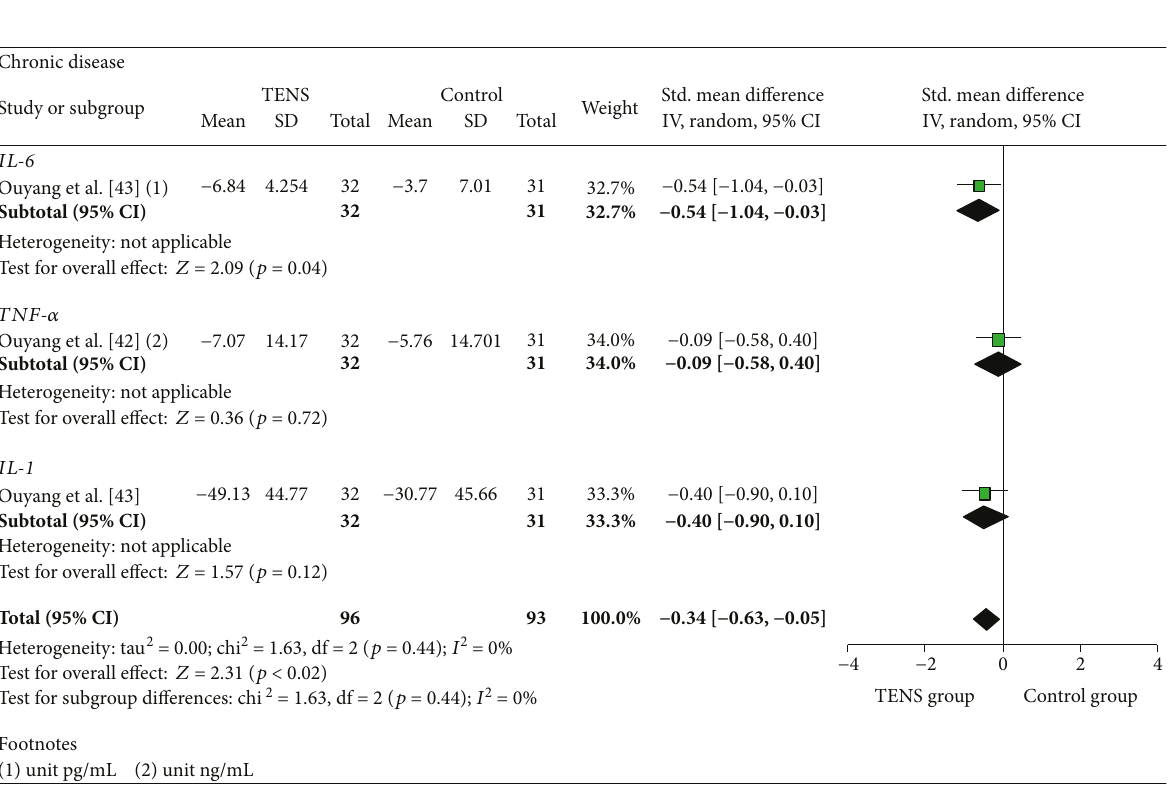
Figure 5: Meta-analysis subgroup postoperative.